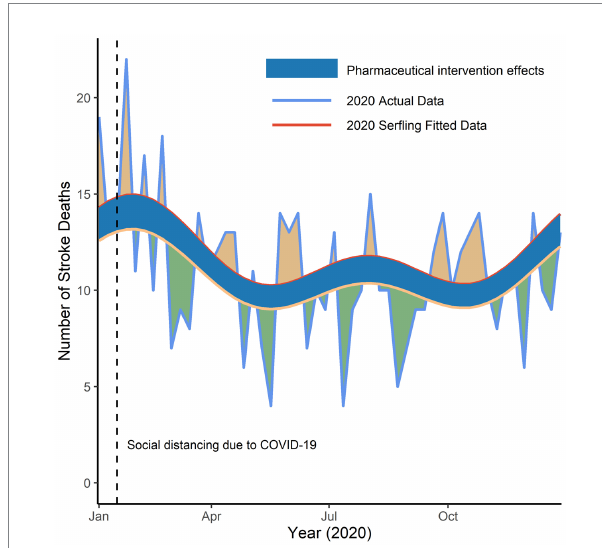
FIGURE 4 Reduction in number of weekly stroke deaths in Deqing, 2020. Yellow line represented adjusted predicted stroke deaths in 2020 after a large-scale social distancing due to the pandemic of COVID-19 was implemented. Blue shadows were presented as the pharmaceutical intervention effects throughout year 2020. Green shadows were presented as the reduction and orange shadows as the increase in actual stroke deaths compared with predicted